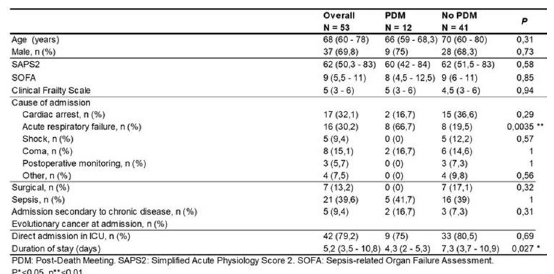
Table 1 Demographic admission data of the overall study popula‑ tion and subset with post‑death meeting acceptance or